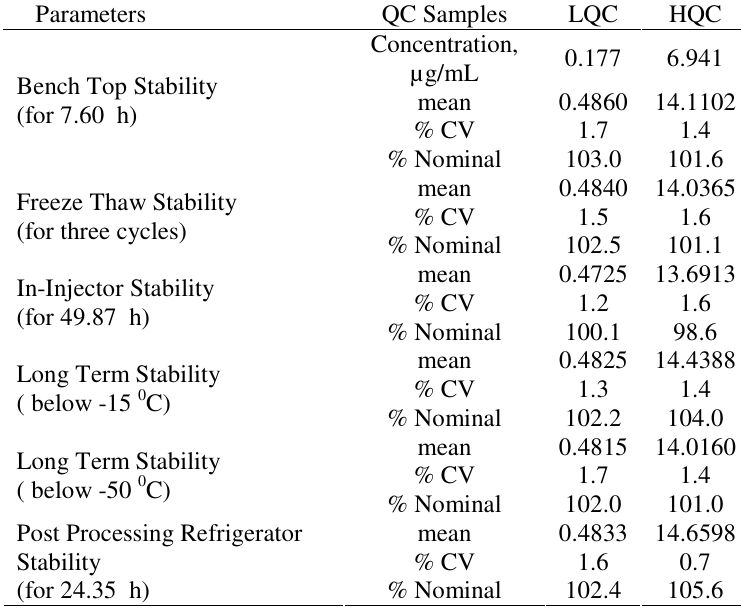
Table 3. Stability of fenofibric acid in human